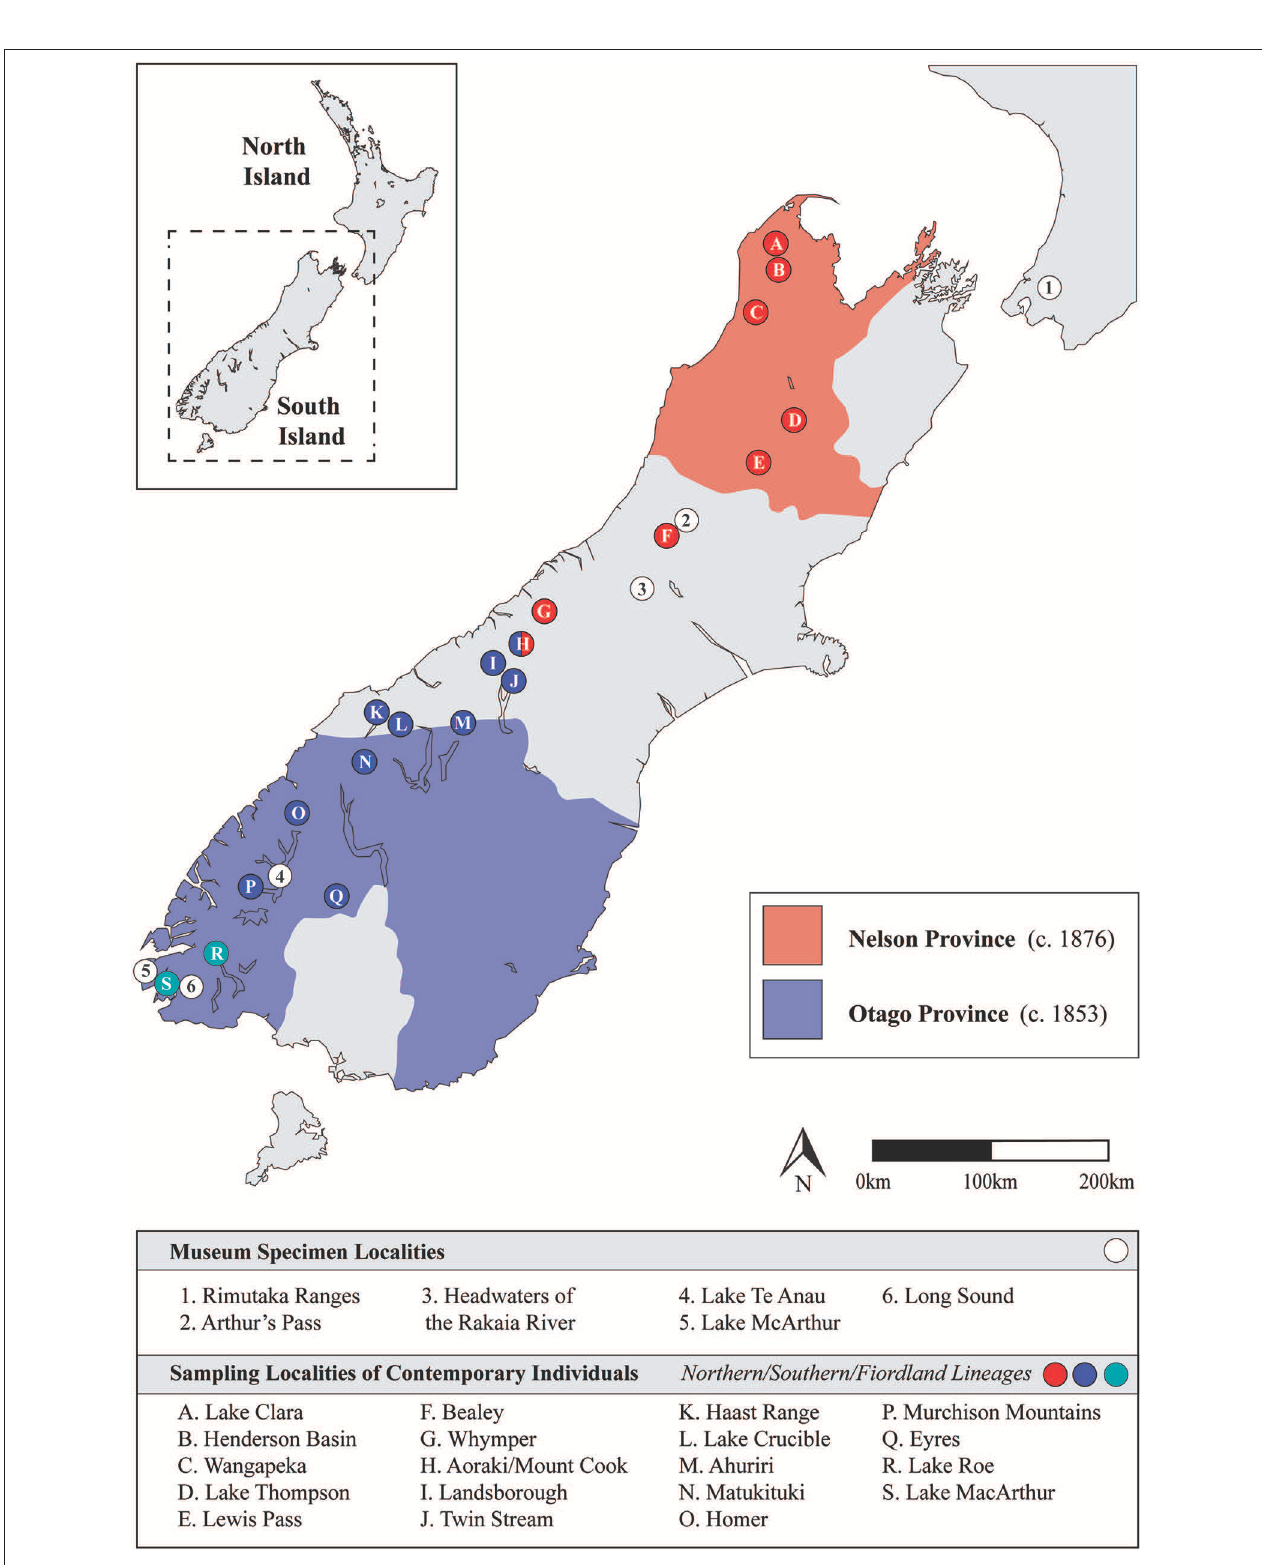
FIGURE 1 | Map of New Zealand denoting relevant regions and localities. The historic Otago and Nelson province boundaries are illustrated, collection localities for museum specimens are indicated via numbered circles, while sampling localities for contemporary individuals (see Weston and Robertson, 2015) are indicated via lettered